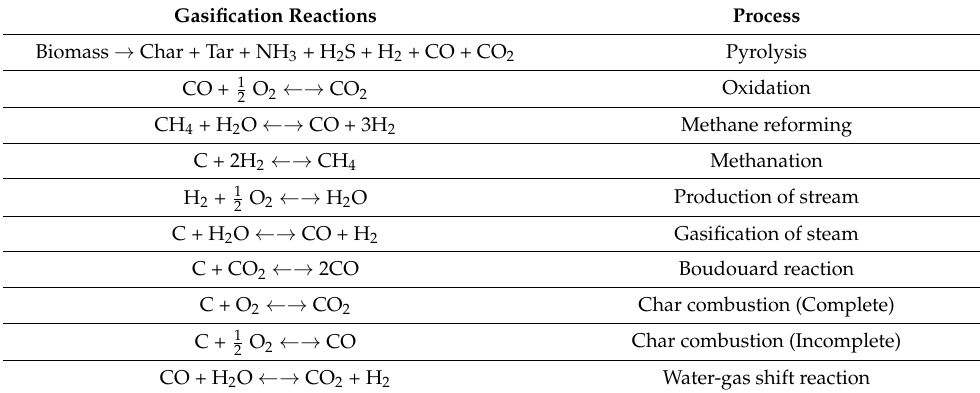
Table 9. The gasification reaction and process involved.